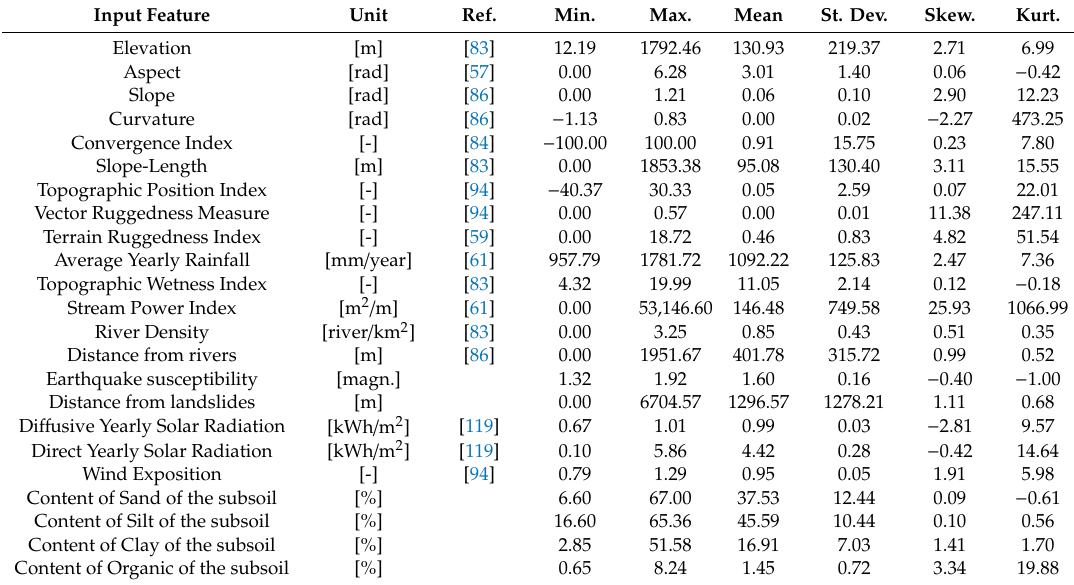
Table 2. Descriptive statistics of the numerical input features.